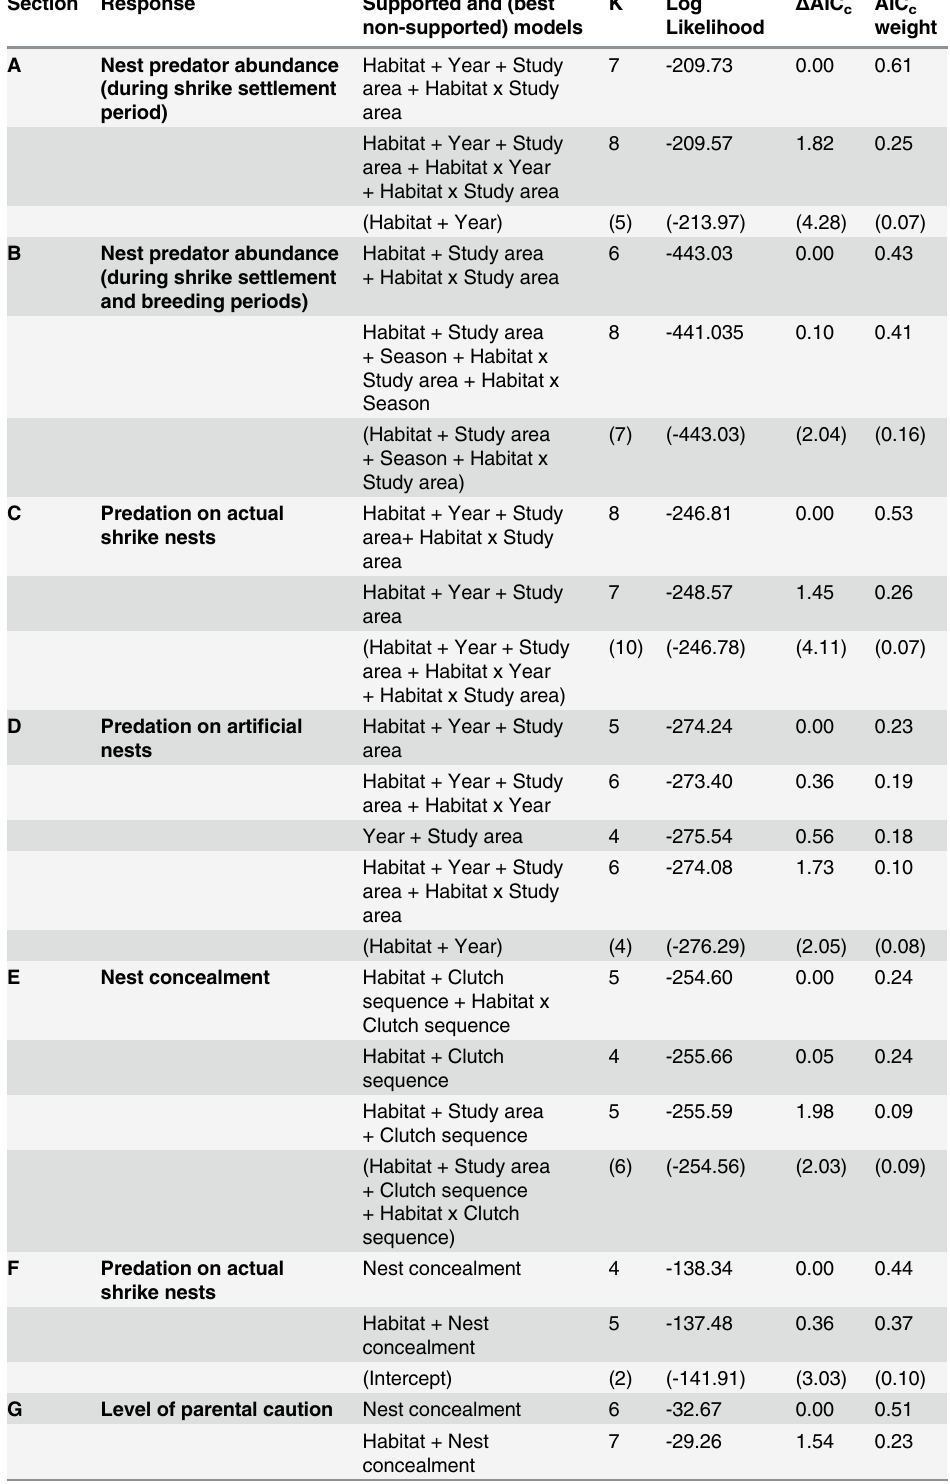
Table 2. Set of supported and best non-supported candidate models along with their respective sup- port according to the model selection procedures. Section